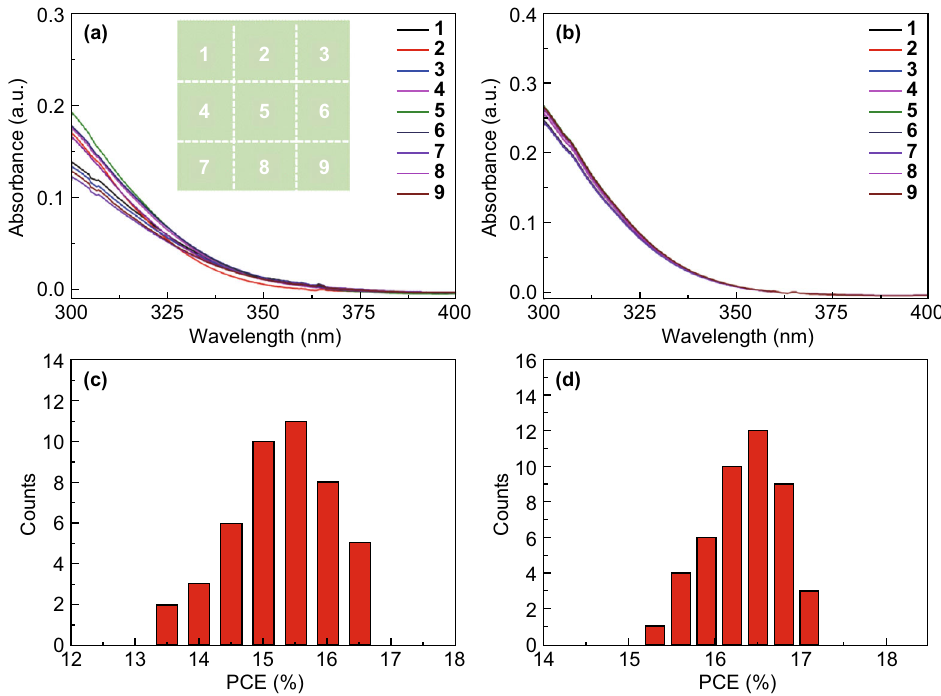
Fig. 5 UV–Vis light absorption spectra of 9 pieces of 2 9 2 cm 2 TiO 2 films obtained by a SC, b SAH. PCE distribution histogram of 45 c SC– TiO 2 -based PSCs, d SAH–TiO 2 -based PSCs. The films and PSCs were fabricated on the 9 sub-areas divided along the white dashed lines on the SC and SAH TiO 2 films (6 9 6 cm 2